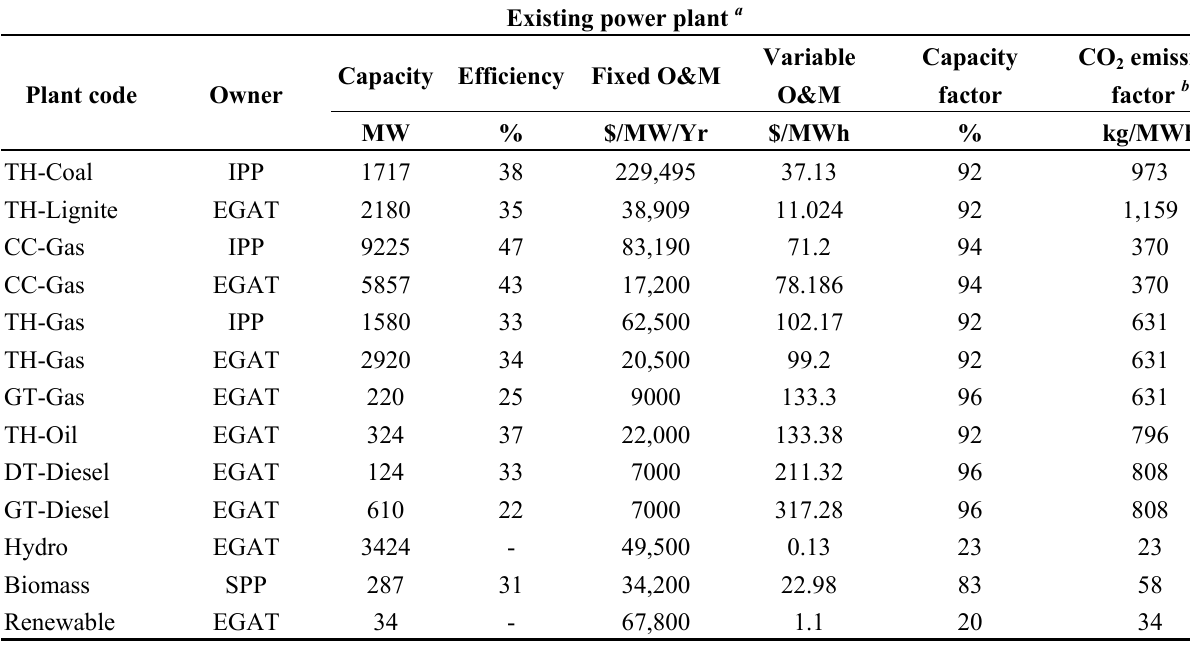
Table 5. Technical, economic and environmental characteristics of existing and candidate power